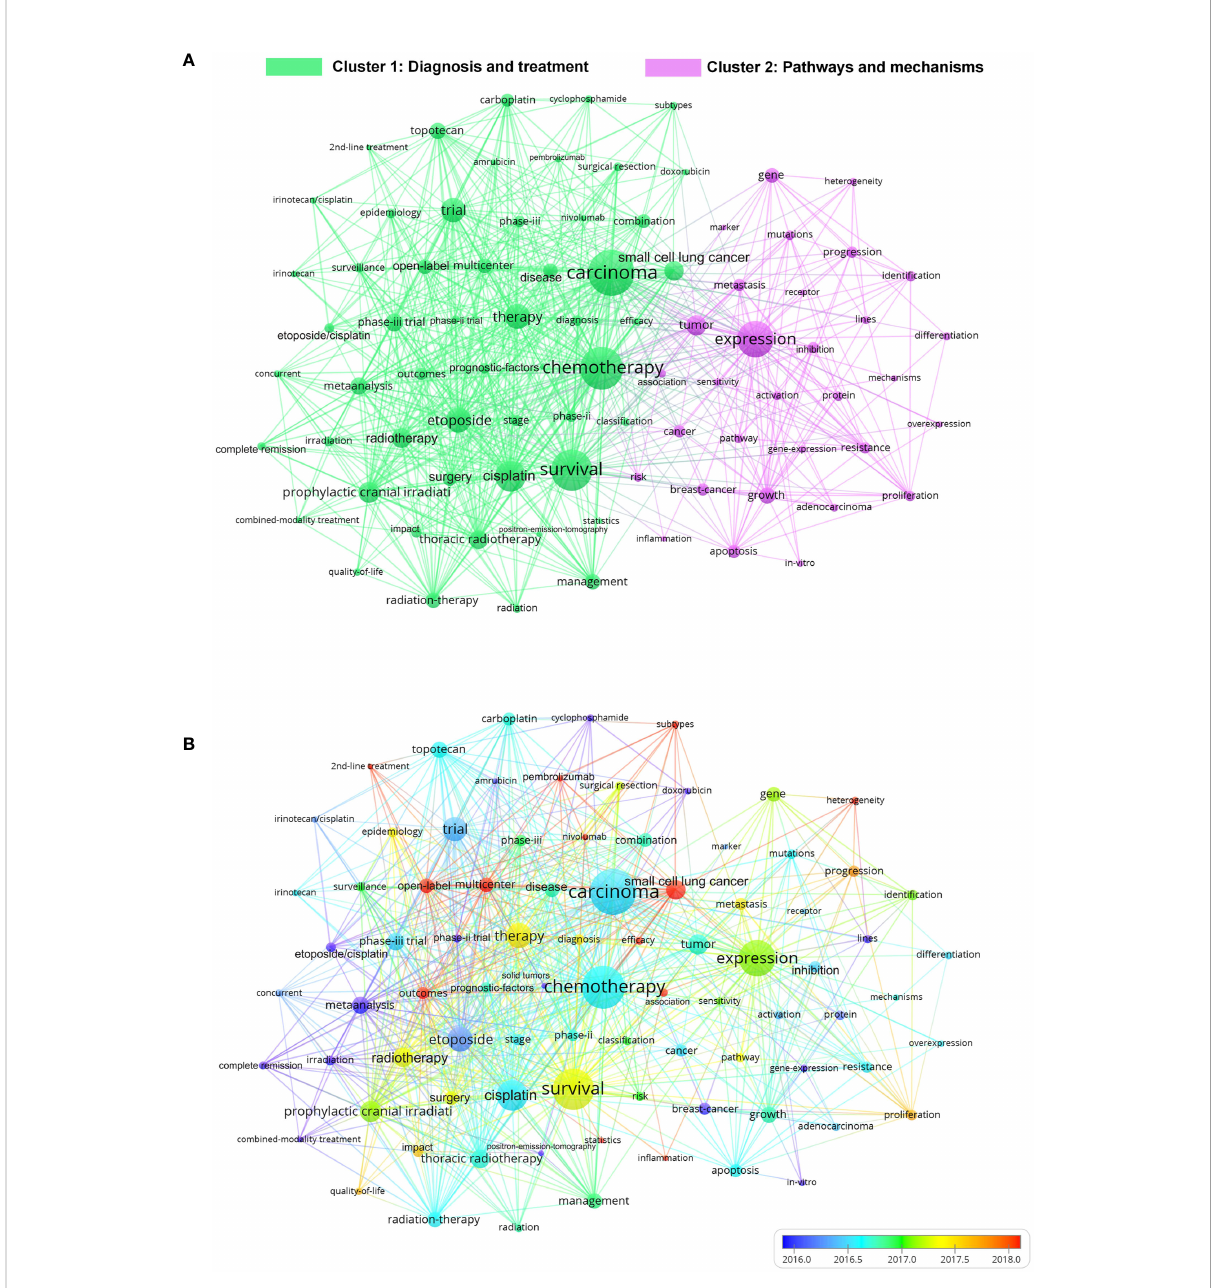
FIGURE 10 (A) Co-occurrence map of keywords on SCLC research generated by the VOS viewer. The keywords in the fi gure are divided into 2 distinct clusters: Cluster1: Diagnosis and treatment; Cluster 2: ;Pathways and mechanism. (B) Overlay map of co-occurrence keywords. The redder node in the fi gure represents the latest time of appearance. That is, the future hotspots we are looking for.